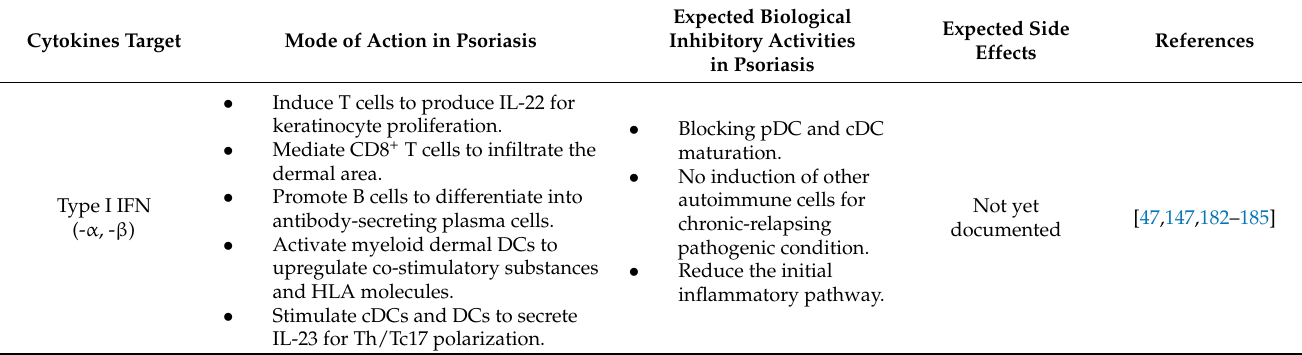
Table 2. Potential cytokines of interest to be targeted in